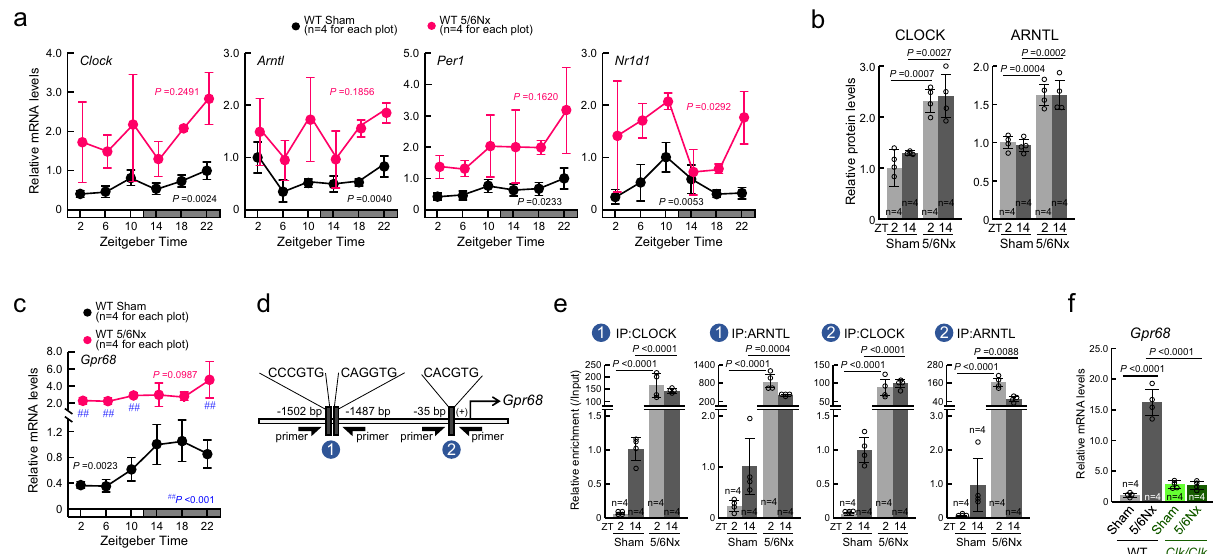
Fig. 5 Disruption of clock gene expression in 5/6Nx monocytes upregulates GPR68 expression. a Temporal mRNA expression pro fi les of Clock , Arntl , Per1 , and Nr1d1 in the circulating monocytes of Sham and 5/6Nx mice. b Temporal expression pro fi les of CLOCK and ARNTL proteins in the monocytes of Sham and 5/6Nx mice. c Temporal mRNA expression pro fi les of Gpr68 in the monocytes of Sham and 5/6Nx mice. d Schematic representation of the mouse Gpr68 gene. The numbers indicate the distance from the transcription start site ( + 1). Black rectangles, E-box. The circled numbers (blue circles) indicate the location on the gene where each of the different primer sets localize for analysis of chromatin immunoprecipitation (ChIP). e The binding of endogenous CLOCK and ARNTL to the Gpr68 upstream region in the monocytes of Sham and 5/6Nx mice at ZT2 and ZT14. f The expression of Gpr68 mRNA in primary cultured monocytes, which were isolated from naive wild-type (WT) or Clk/Clk mice. The mRNA levels of Gpr68 were assessed after treatment with serum from Sham or 5/6Nx WT mice for 24 h. For ( a – c ) and e , the mean peak value of the Sham group was set as 1.0. For ( a and c ), there was a signi fi cant time-dependent variation in the mRNA levels of Clock , Arntl , Per1 , Nr1d1 , and Gpr68 in the Sham group (one-way ANOVA; P -value are shown in each graphs). For all panels, graphs show the mean ± SD of individual mice in independent experiments ( n = 4 for all groups). Statistical signi fi cance was determined using two-way ANOVA with Tukey – Kramer post hoc tests ( b , e , f ). Numbers and P -values are shown in each graph. Source data are provided as a Source Data fi